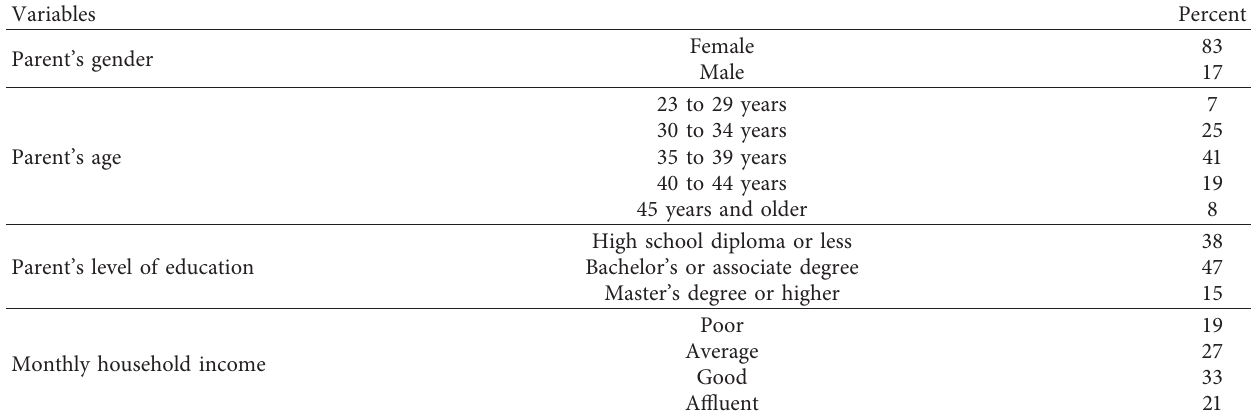
Table 7: Parents’ information.